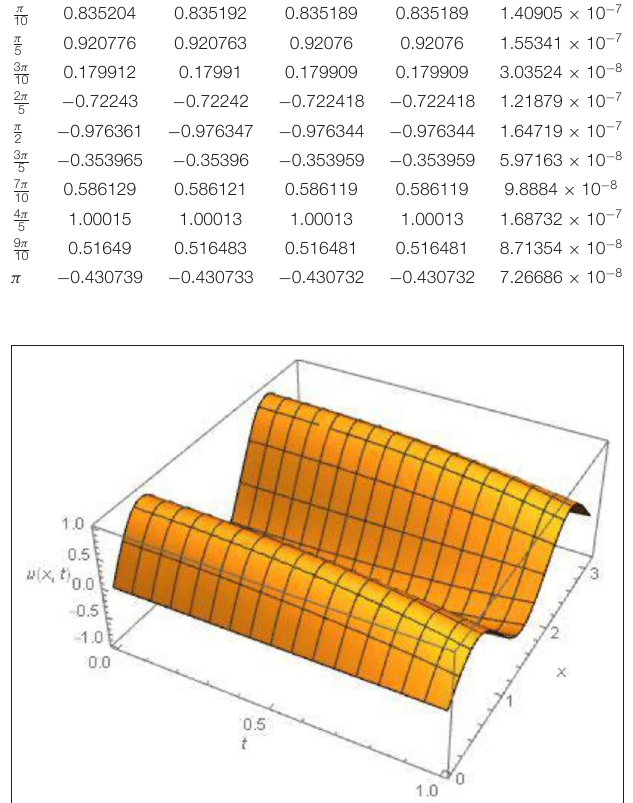
FIGURE 2 | Surface of Approximate solution for TFPPDE (20) with α